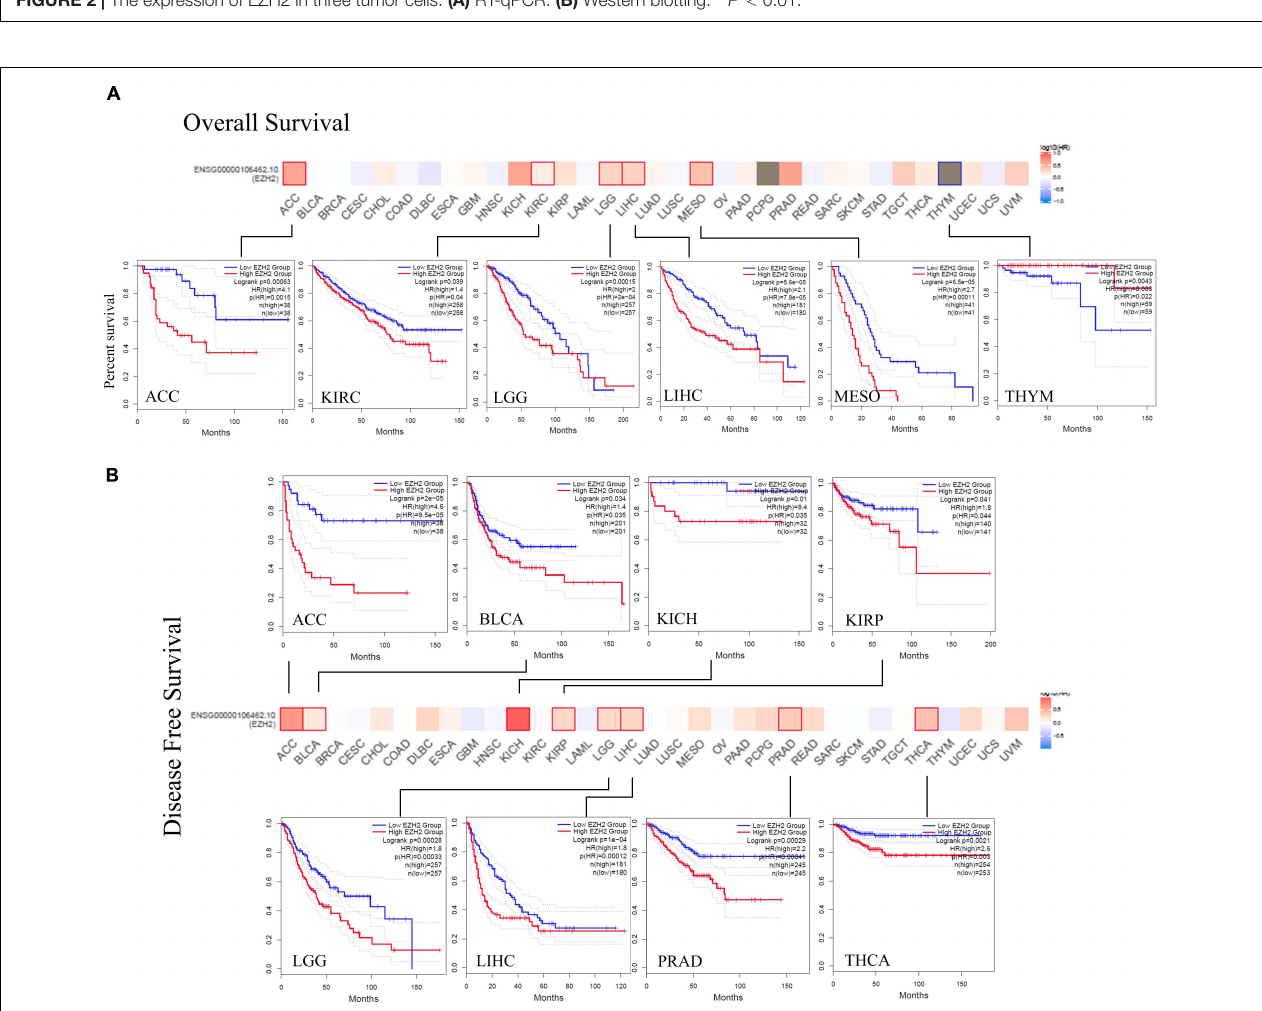
FIGURE 3 | Correlation between EZH2 gene expression and survival prognosis of cancers based on the TCGA data. The overall survival (A) and disease-free survival (B) analyses of different tumors by EZH2 gene expression were perform in the form of a survival map and Kaplan–Meier curves.